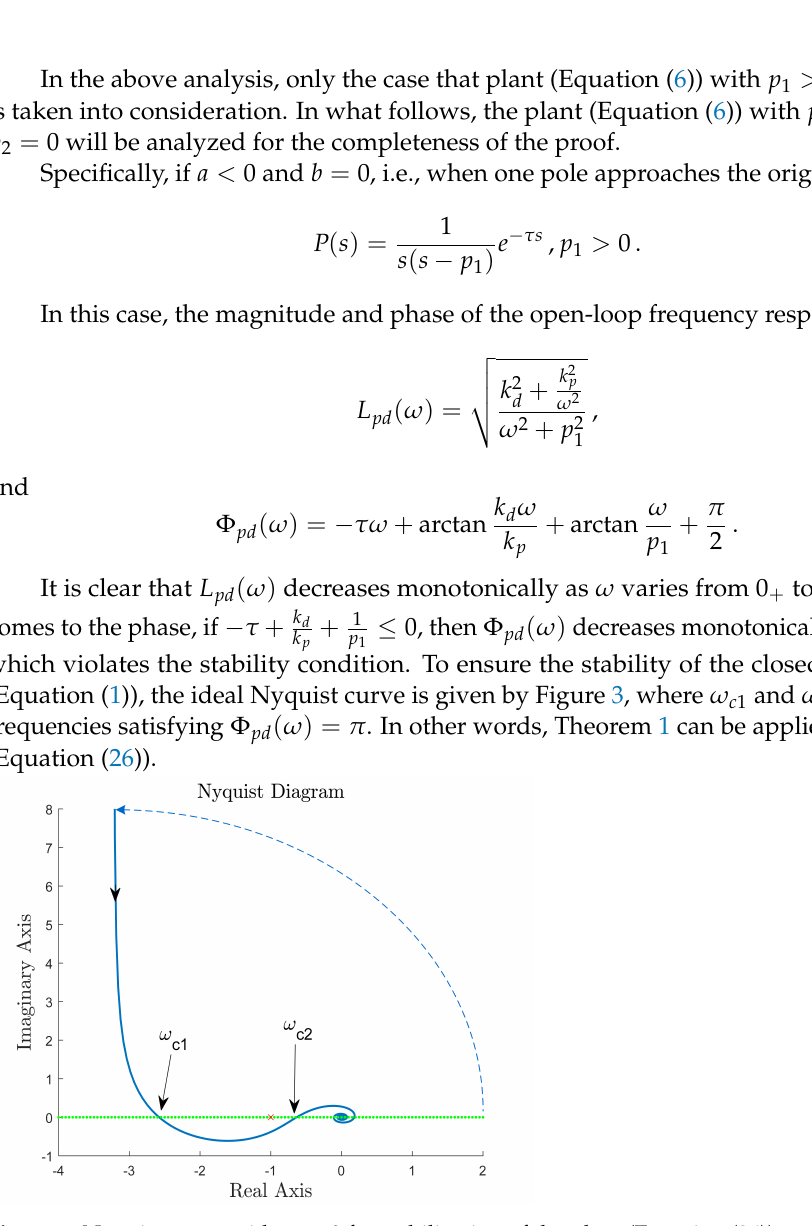
Figure 3. Nyquist curve with ω > 0 for stabilization of the plant (Equation